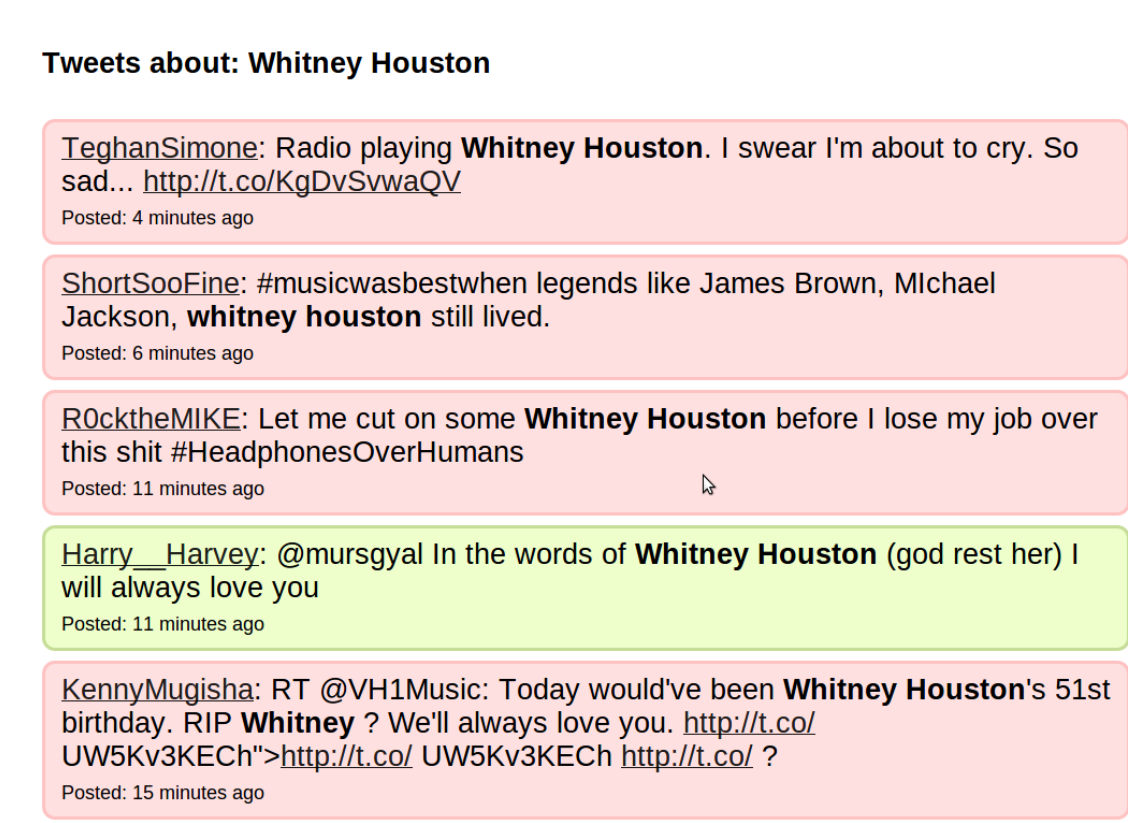
Figure 1. Tweets about Whitney Houston’s